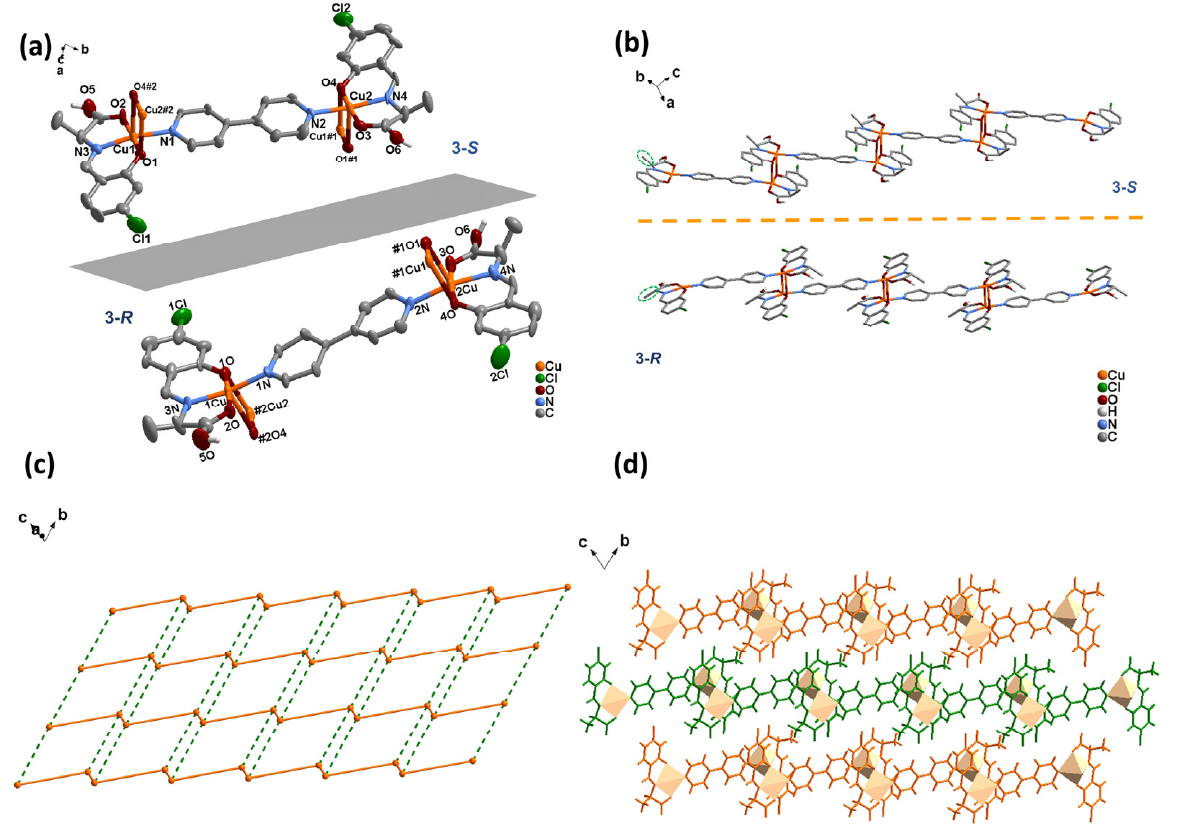
Figure 3. ( a ) Coordination environment diagram of 3- S / R with 50% thermal ellipsoid probability (hydrogen atoms have been omitted for clarity); symmetry mode: #1: x, 2 + y, − 1 + z; #2: x, y, 1 + z; ( b ) 1D structure of 3- S / R as viewed from the b axis; ( c ) 2D topological structure of 3- S as viewed from the a axis, the green dotted line denotes the hydrogen bond; ( d ) the 3D supramolecular struc- ture of 3 -S is packed in an ABAB form via van der Waals forces from the a axis.